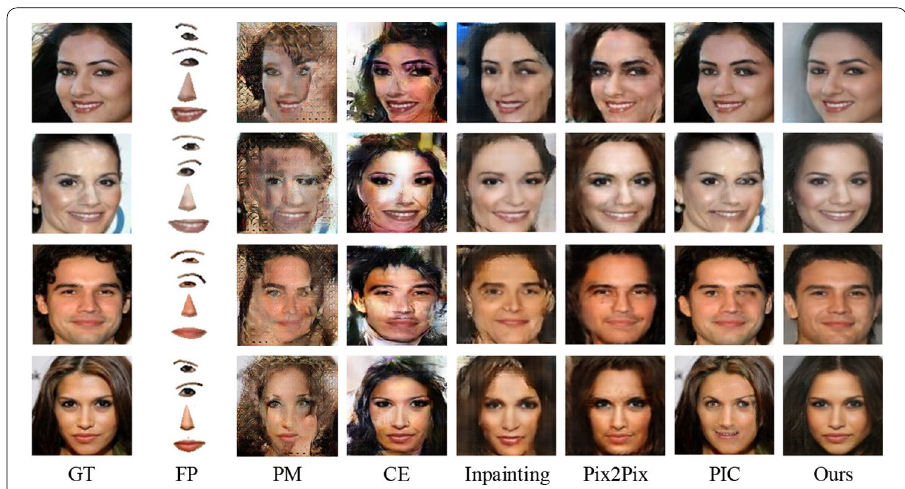
Fig. 9 Comparison of some methods for image generation based on facial parts. Columns from left to right: the original facial images (GT is short for the ground truth), the facial parts (FP), the results of the modified image completion method. PatchMatch (PM) [40], Context Encoder (CE) [5], Image Inpainting [7], pix2pix [16], Pluralistic Image Completion (PIC)